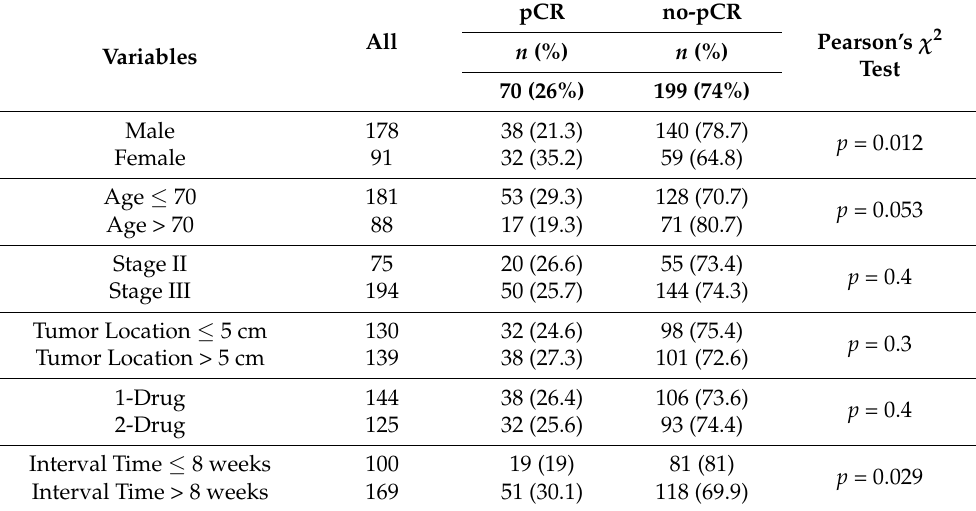
Table 4. pCR rate according to patients’ characteristics and treatment